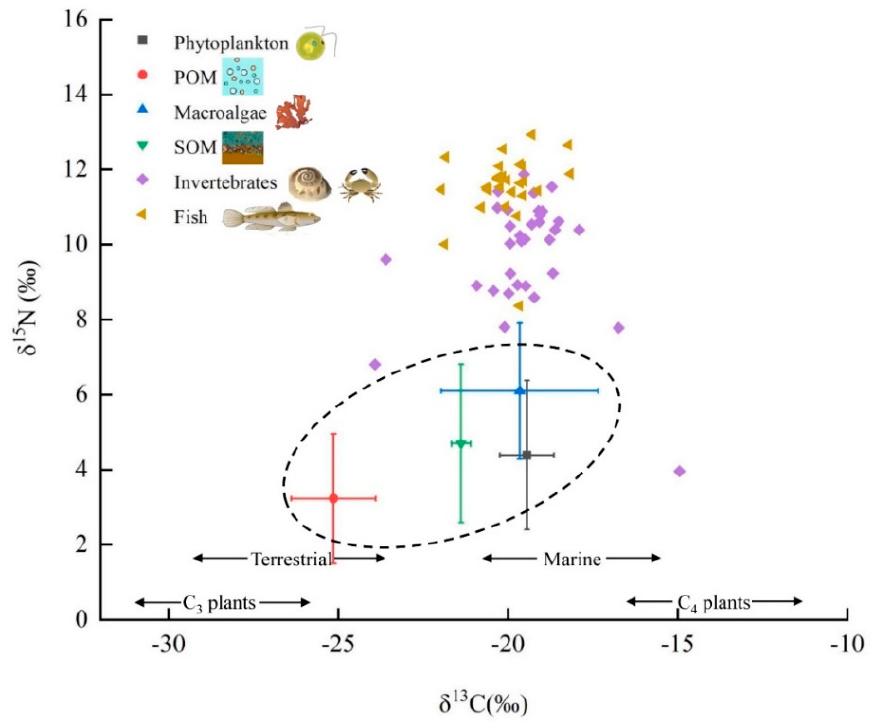
Figure 3. Stable isotope biplot ( δ 13C and δ 15N‰, mean ± SD) for the benthic food web (basal carbon sources and consumers) in the sea adjacent to the Miaodao Archipelago. Symbols represent the different functional groups. The dashed ellipse represents the main carbon sources (primary producers); green and the inverted triangle represent macroalgae, in which S. horueri , G. turuturu , and U. pertuca are the main macroalgae. The error bar is the 95% confidence interval. The figure indicates two expected isotope patterns (expected marine-terrestrial patterns and expected C3–C4 plant patterns).